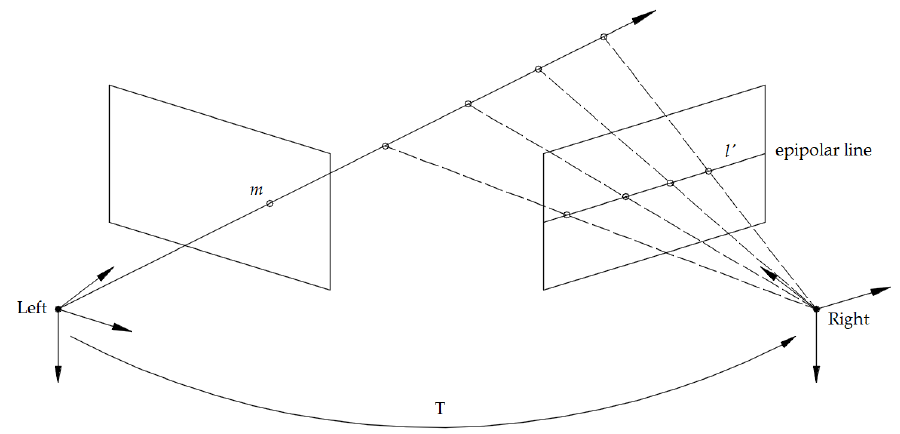
Figure 2. Illustration of the fundamental matrix constraint.